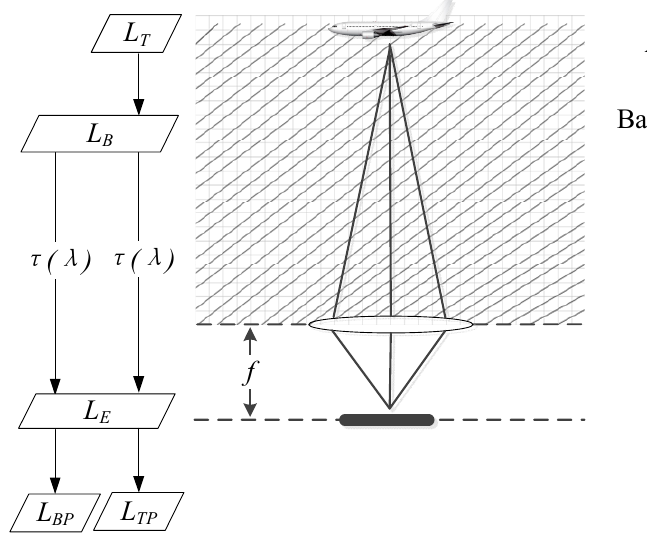
Figure 5. Process of camera receiving infrared radiation.